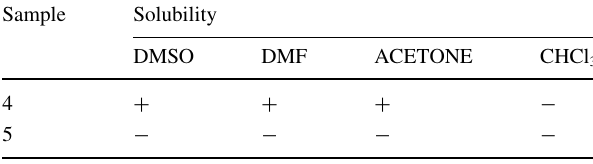
Table 3 Solubility of depolymerization products of coal